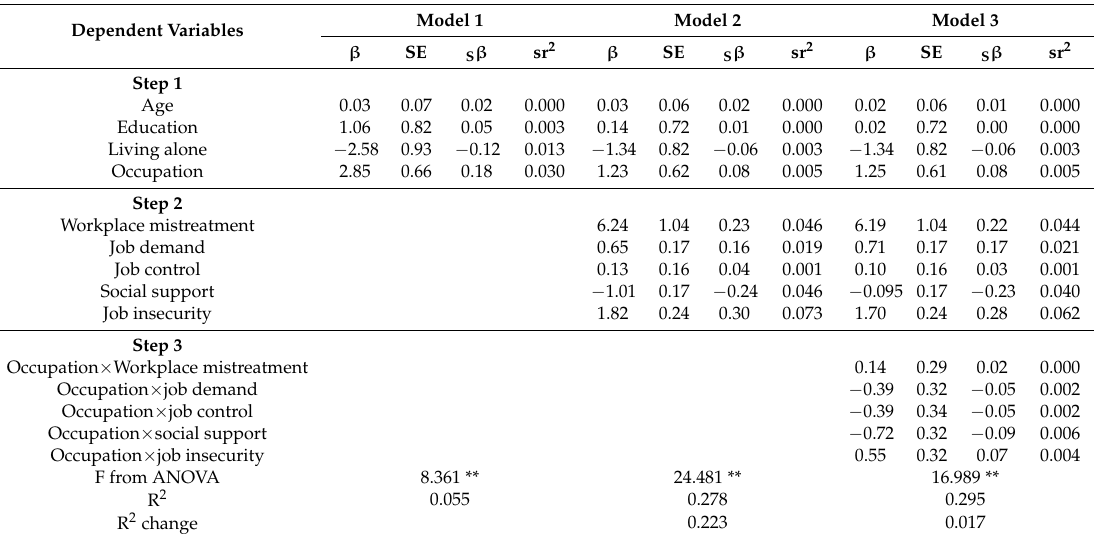
Table 2. Predictors for depressive symptoms among women workers: hierarchical multiple regression analysis ( N = 583).